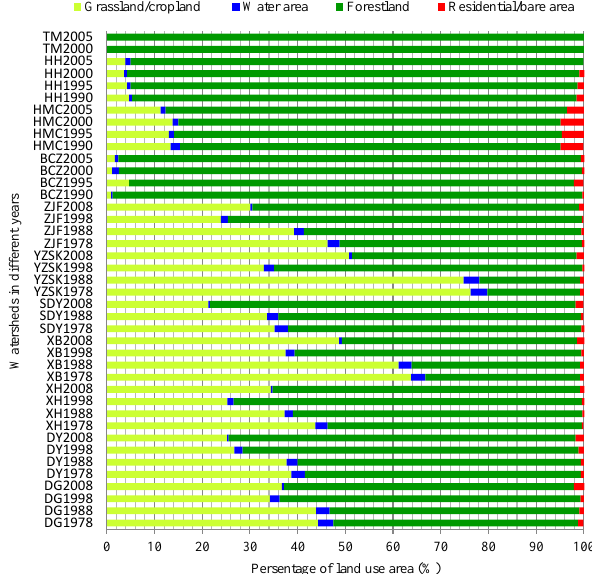
Figure 7. Land use composition of watersheds in different year used for annual water balance model building. For example, DG1978 refers to the Dage watershed in 1978. Data prior to 2001 were used for the model calibration. Data after 2001 were used for the model